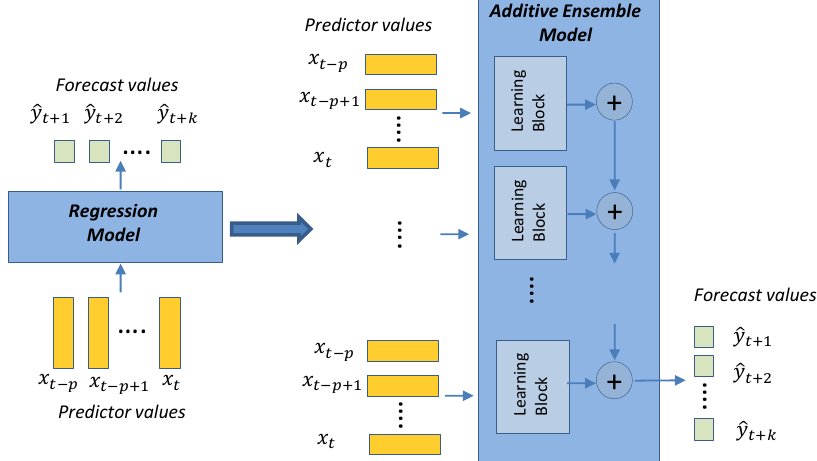
Figure 5. Detail of the deep learning ensemble models used in this work.